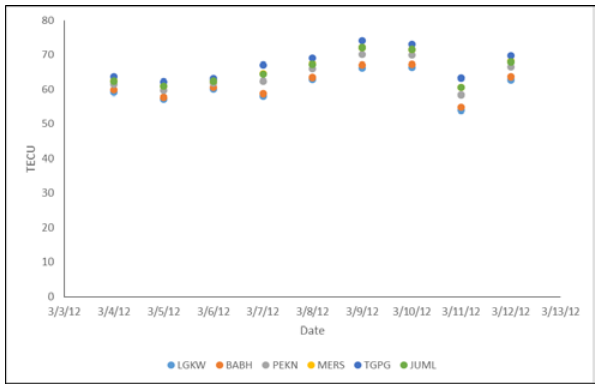
Figure 6. The variation of TEC (in TECU) changes during flare X5.4 for all selected MyRTKnet stations from 3 rd – 12 th March 2012 using Bernese.